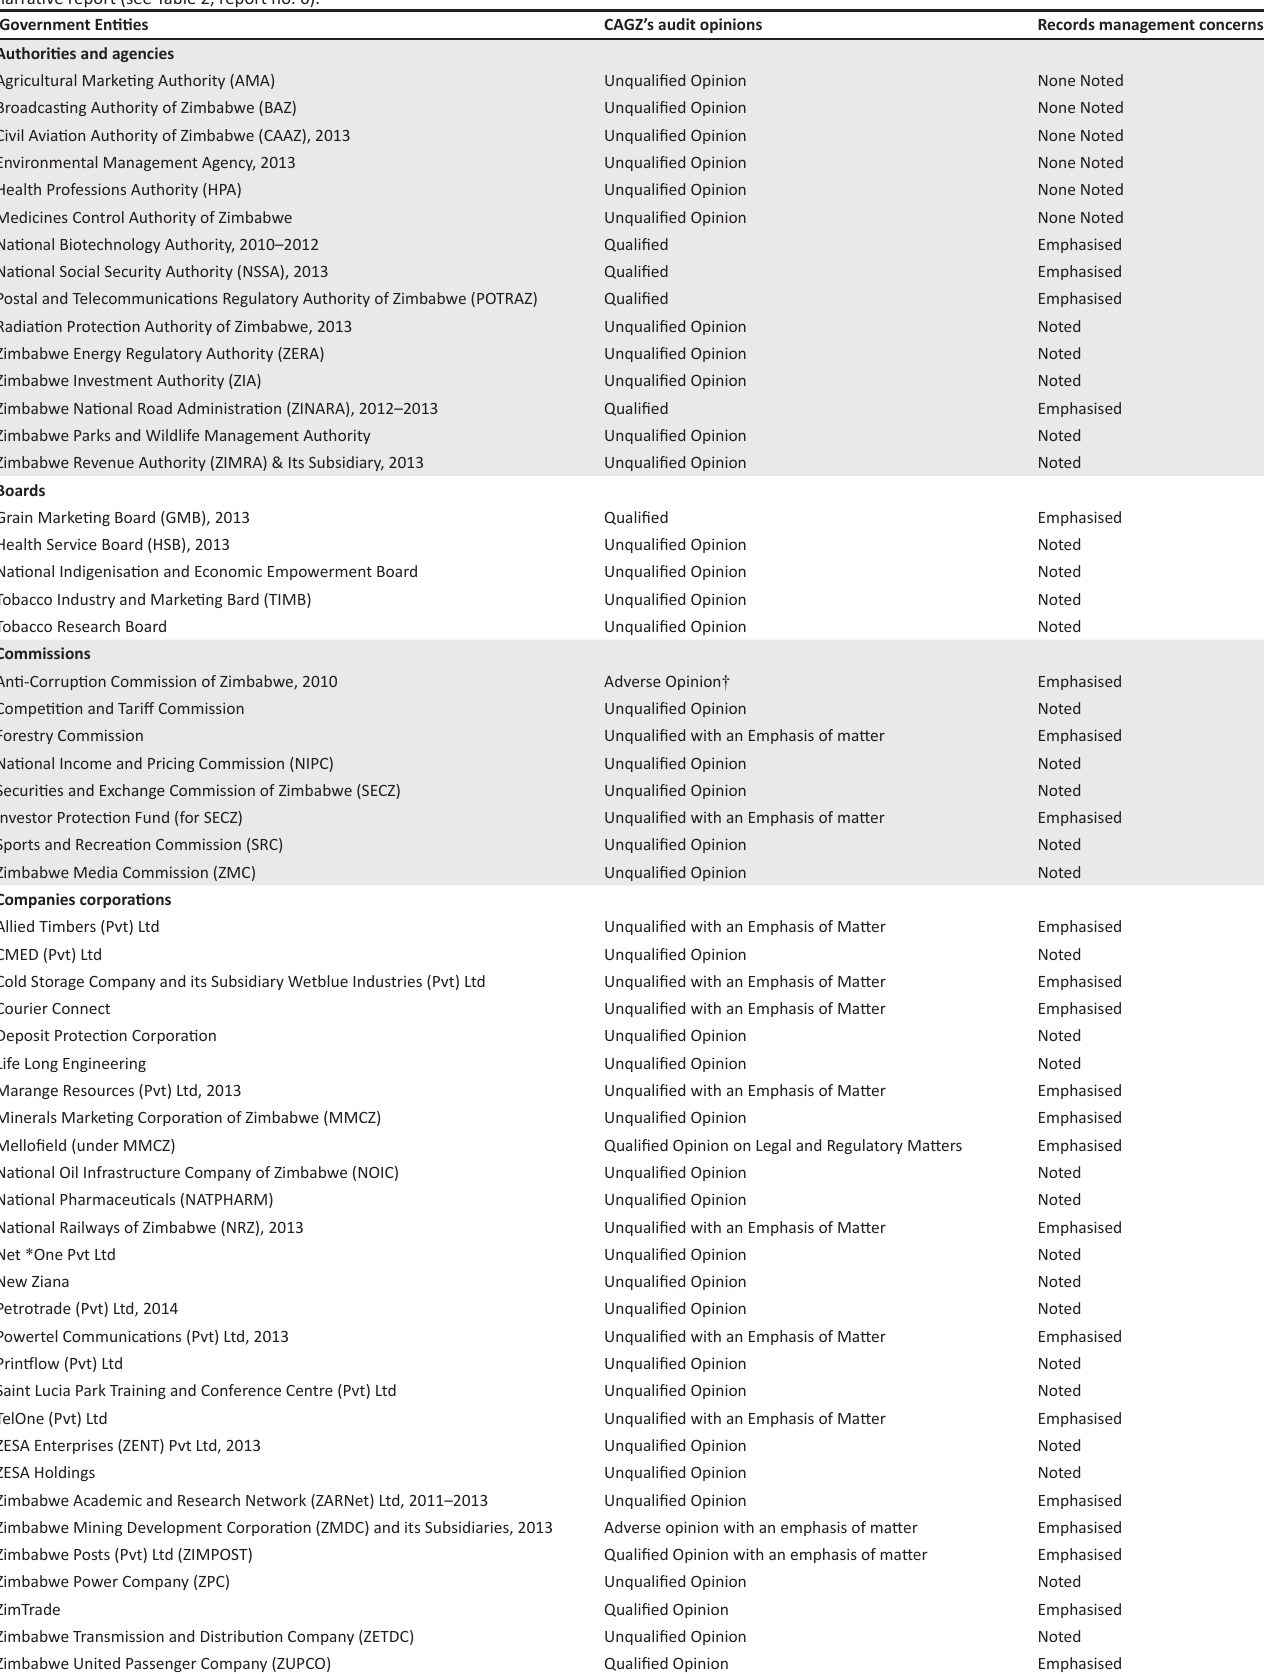
TABLE 1: The Comptroller and Auditor General of Zimbabwe audit opinions and records management concerns in state enterprises and parastatals from the 2014 narrative report (see Table 2, report no.